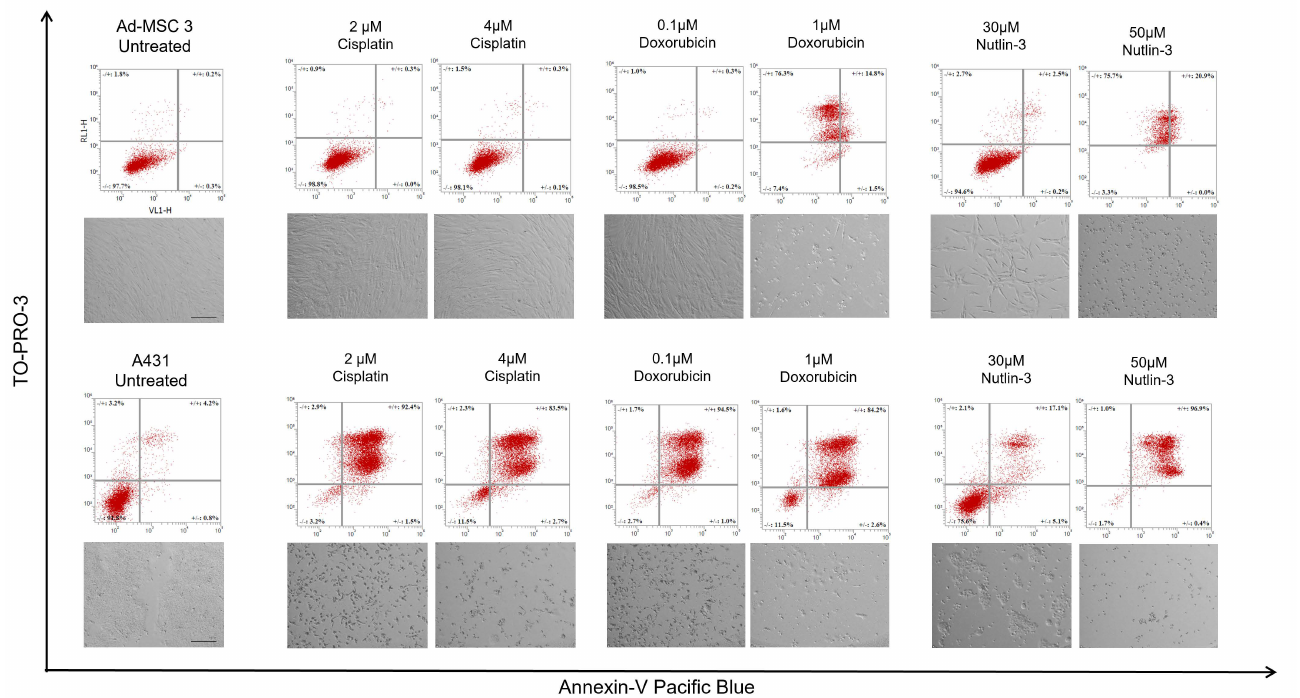
Figure 5. Apoptosis was induced only in A431 cancer cells. 2 µ M and 4 µ M cisplatin, 0.1 µ M and 1 µ M doxorubicin, and 50 µ M nutlin-3 treatment caused apoptosis in A431cells ( lower row). 30 µ M nutlin-3 treatment shows low number of apoptotic A431 cells. None of these concentrations induced apoptosis in Ad-MSC 3 cells ( upper row).